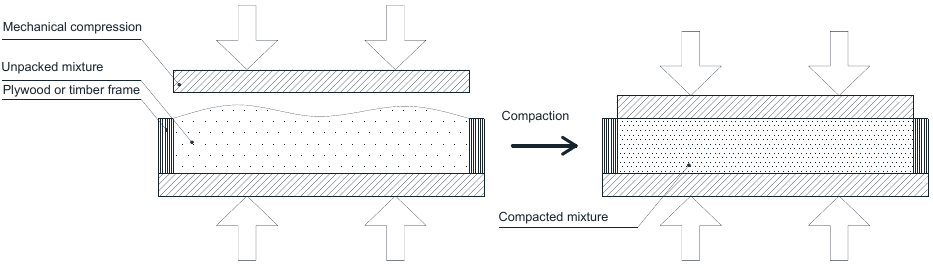
Figure 8. Figure 8. Discontinuous production method of semi-dry gypsum EPS composite with pressure ap- pressure application. plication.